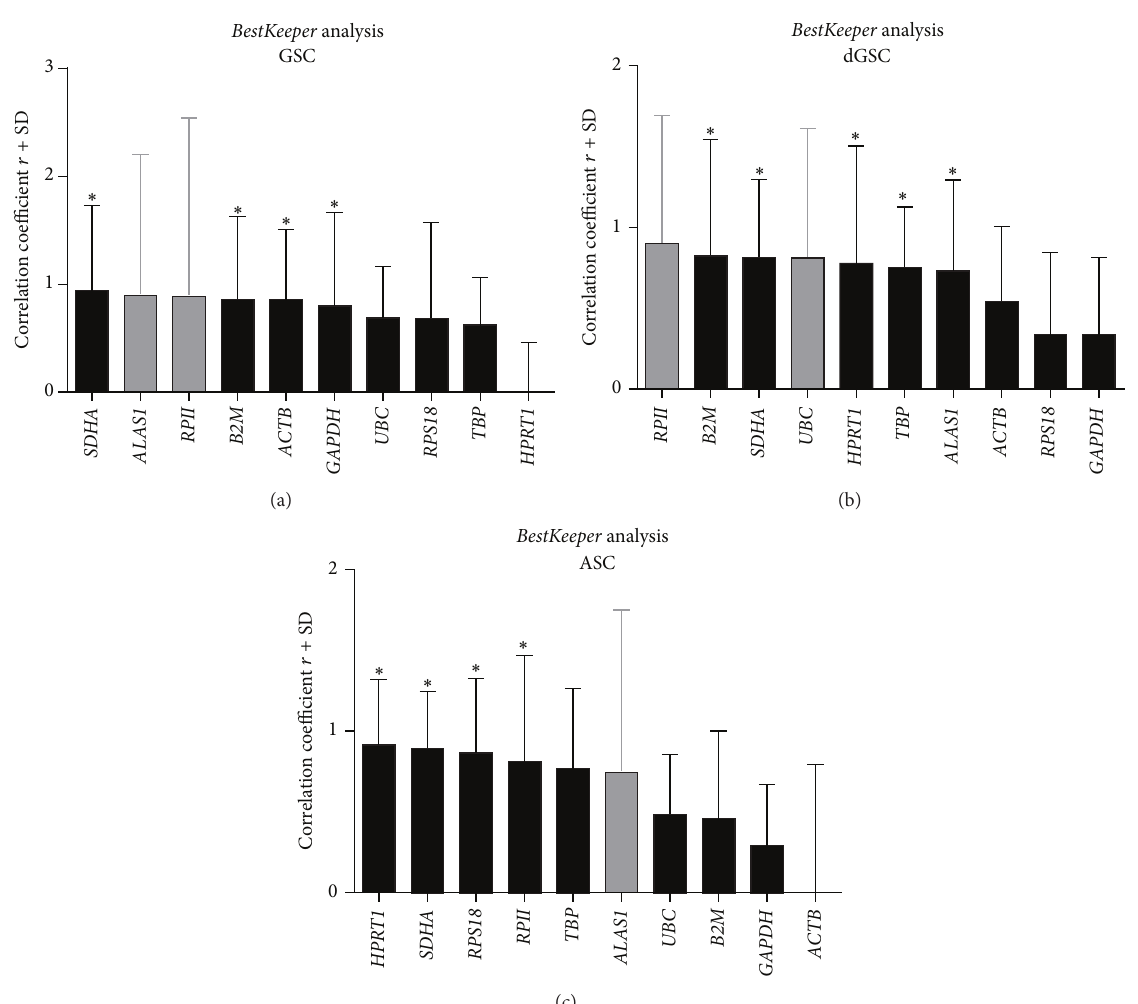
Figure 5: Ranking of the most stable HKGs with BestKeeper analysis for GSC (a), dGSC (b), and ASC (c). Bars represented the coefficient of correlation 𝑟 , while error bars represented the standard deviation (SD). Ideal reference gene had low SD and a high 𝑟 . ∗ 𝑝 ≤ 0.05 .